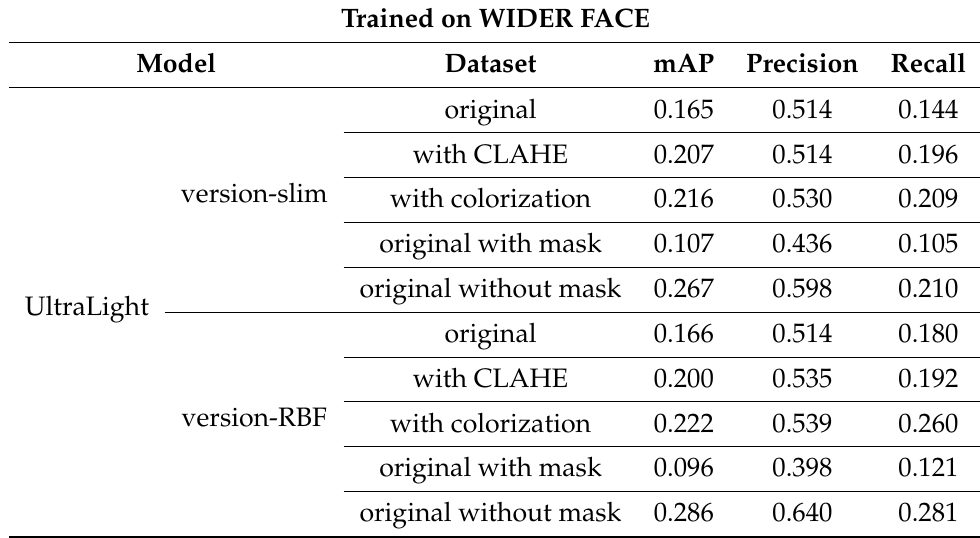
Table 3. Results obtained for testing model trained on WIDER FACE